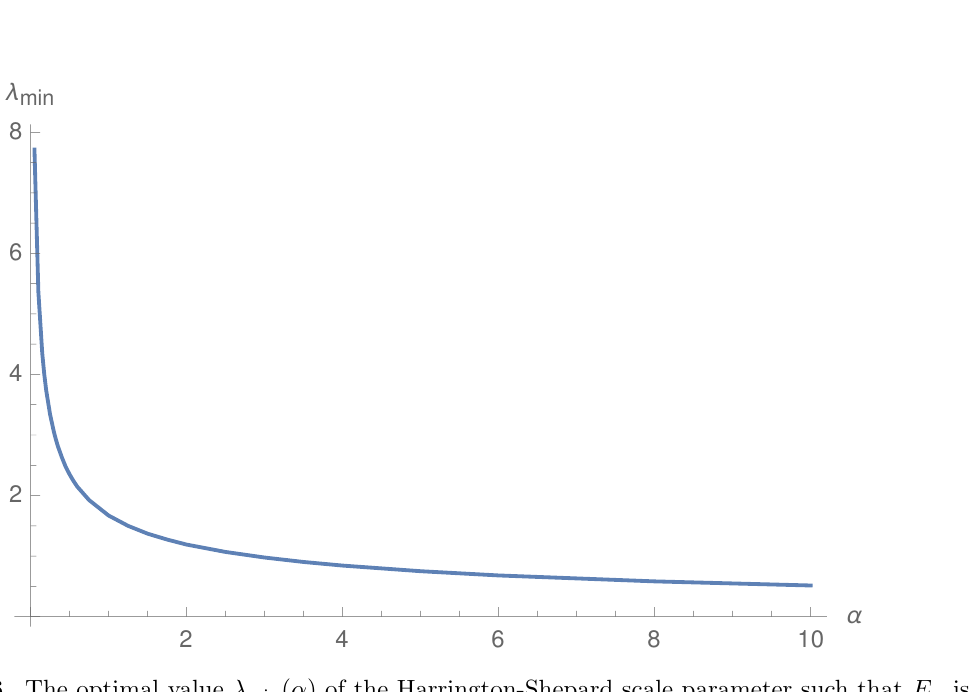
Figure 6. The optimal value (cid:21) min ( (cid:11) ) of the Harrington-Shepard scale parameter such that E (cid:11) is minimised.